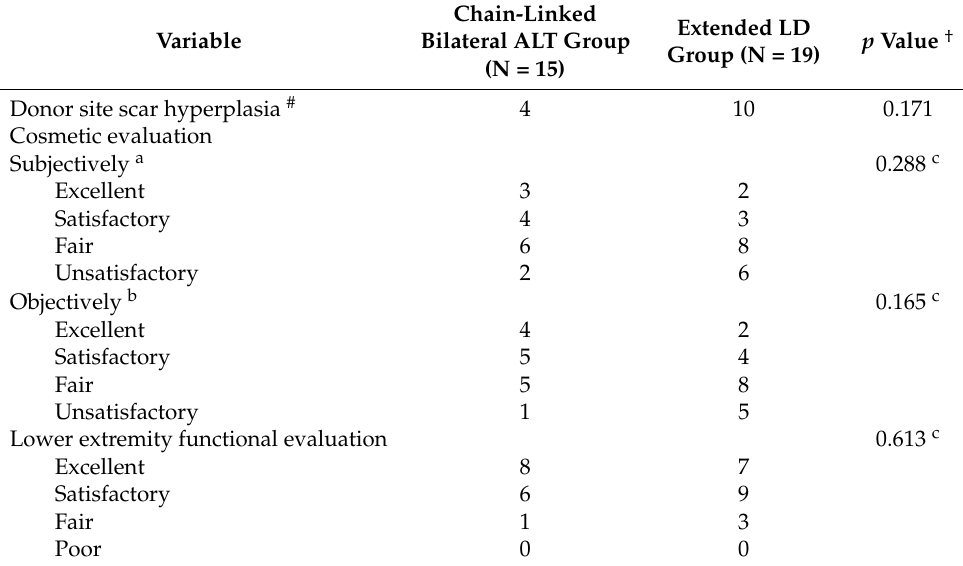
Table 4. Long-term follow up results.